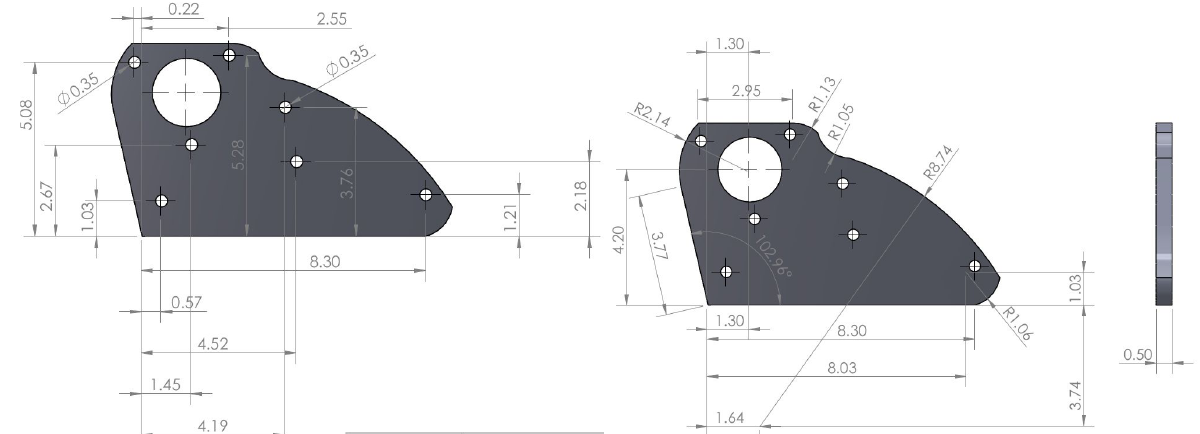
Figure 9. The dimensions of the driving gearbox support fixture. All units are in the metric system